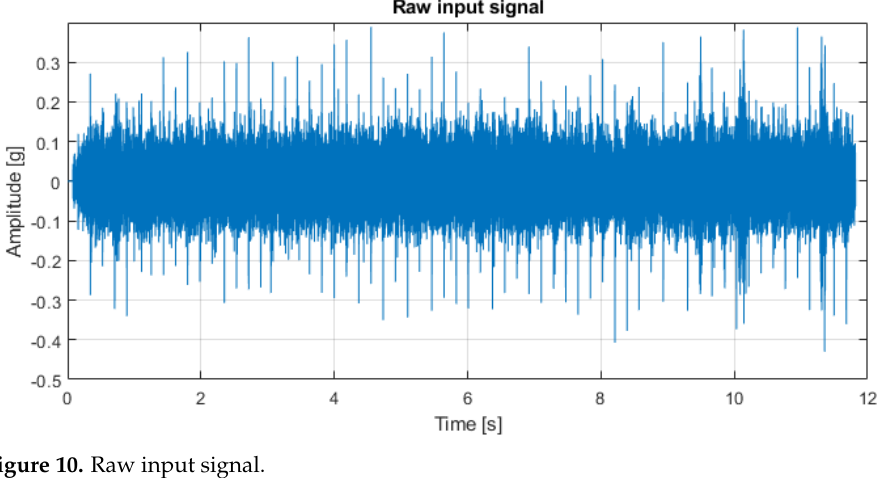
Figure 10. Raw input signal.